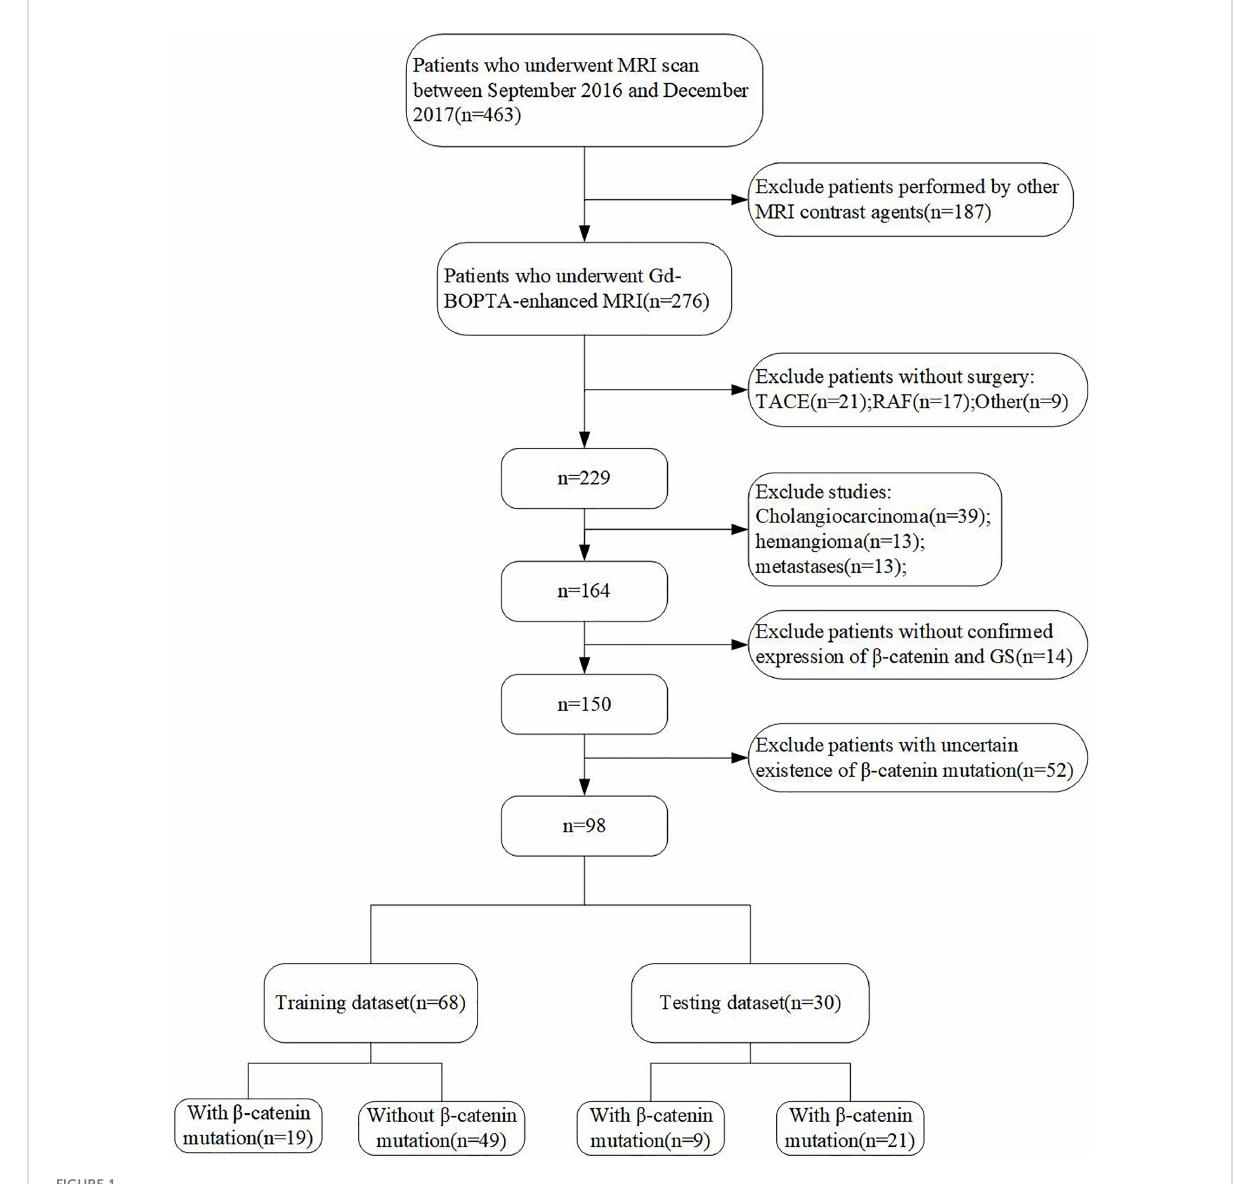
FIGURE 1 Flow chart of the study population. HCC, hepatocellular carcinoma; RAF, radiofrequency ablation; TACE, transcatheter arterial